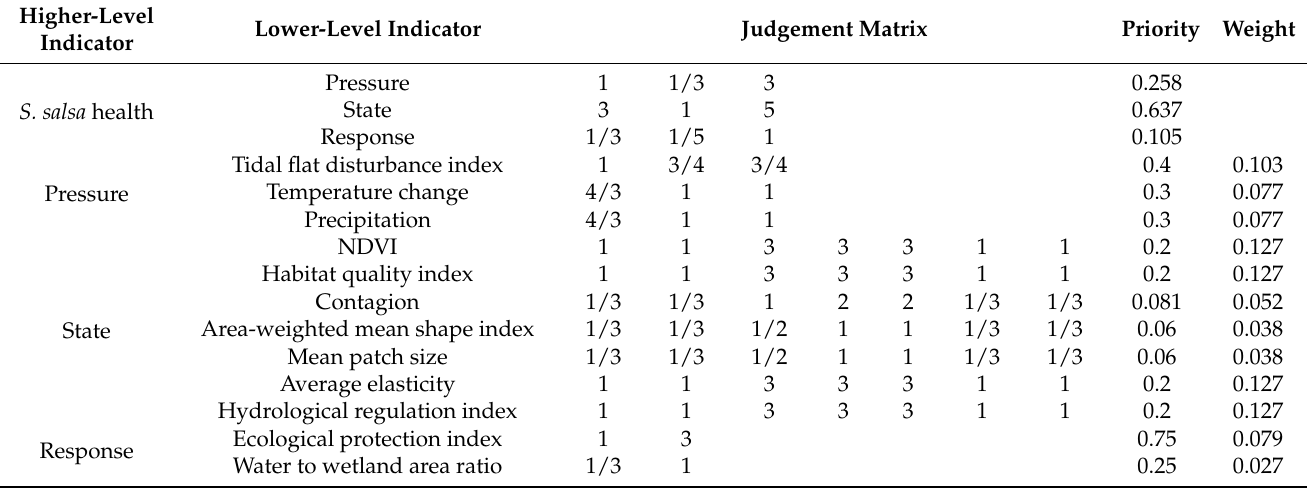
Table 4. The correlation matrix and weights of the indicators using the AHP